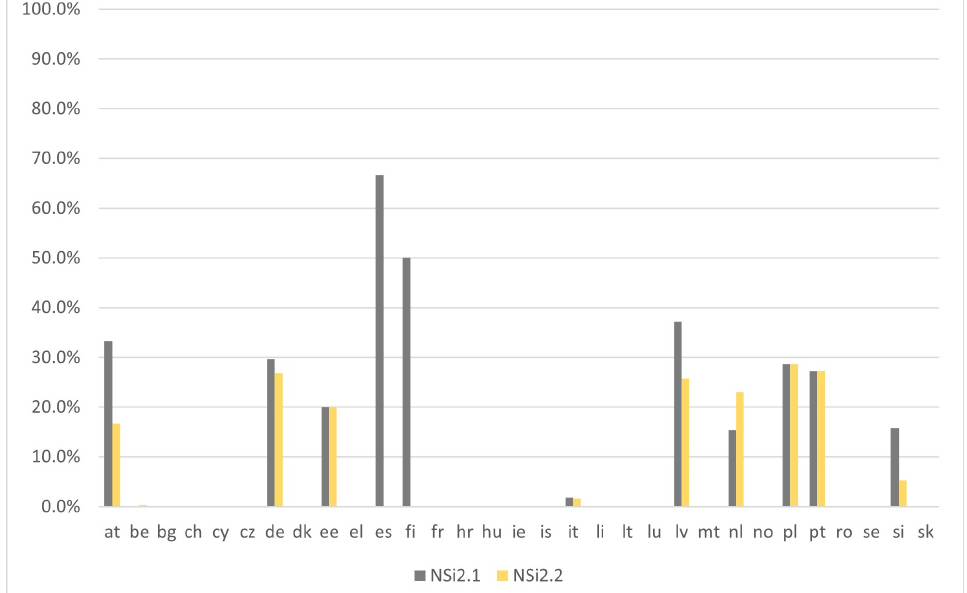
Figure 13. Indicators NSi2.1 and NSi2.2 for